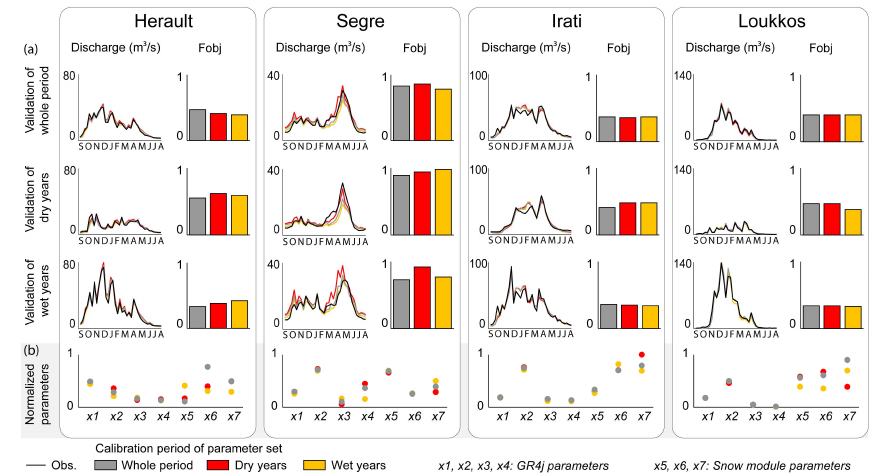
Figure 4. Cross-calibration/validation of the hydrological model. (a) Seasonal representation (from September to August) of simulated and observed runoff during the whole period (WHO, first row), dry years (DRY, second row) and wet years (WET, third row) according to parameter sets optimized, respectively, for the whole period (in grey), dry years (red) and wet years (yellow). F obj ( F obj = ( 1 − NSE ) + ( 1 − NSE log ) +| VE C |+ VE M ) is computed on daily series. F obj is optimal at 0, but is considered satisfactory below 1. (b) Normalized model parameters obtained over the three calibration